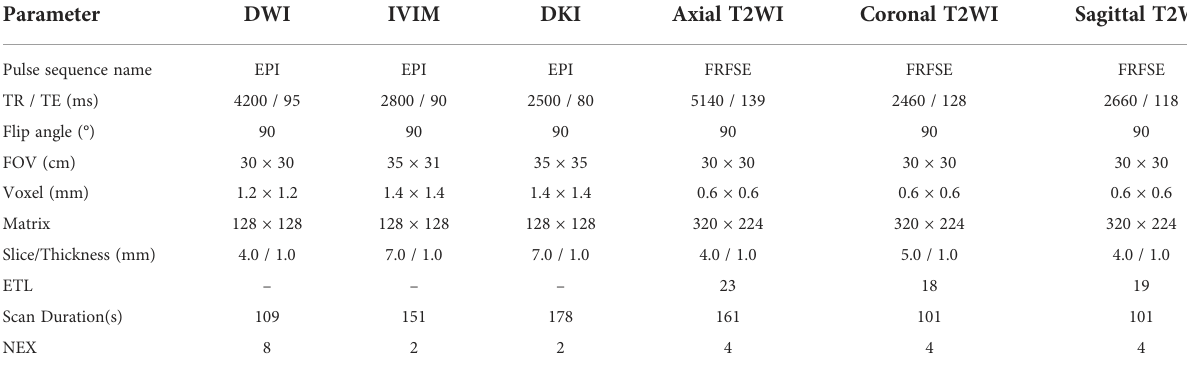
TABLE 1 MR sequences parameters of DWI, IVIM, DKI and T2WI.